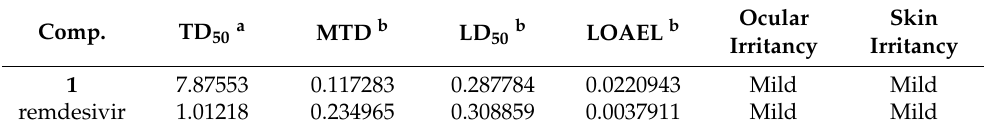
Table 6. Toxicity profiles of jusan